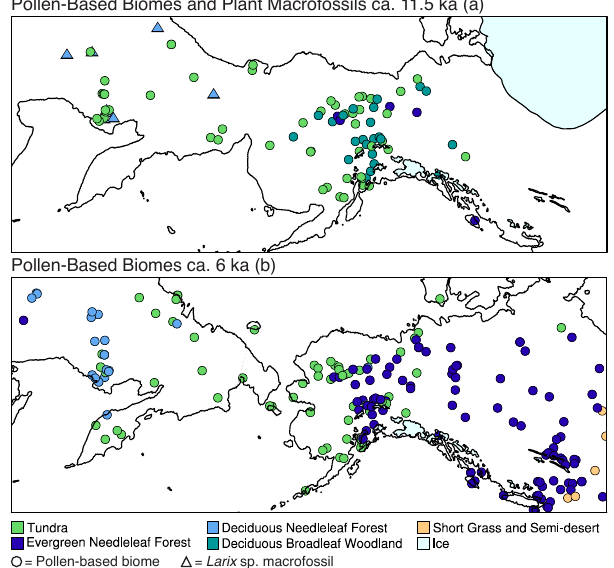
Figure 3. Pollen-based biomes for ca. 11.5ka ( a ; this study) and ca. 6ka ( b ; from Prentice et al., 2000; Bigelow et al., 2003). The 11.5ka pollen patterns indicate deciduous broadleaf woodland in Alaska and Canada (a) , but in Siberia this biome is identified from macro- fossils only (not shown; see Sect. 2.2.8). At 6ka deciduous needle- leaf forest in Siberia is identified from widespread Larix pollen. The main difference between 6ka and modern is the truncated distribu- tion of evergreen needleleaf forest in western Alaska at 6ka. Biome identities and colors map onto the RegCM land-cover PFTs (plant functional types) in Fig. 4. Ice from Dyke et al. (2003) and coastline inferred from Peltier (1994) topographic